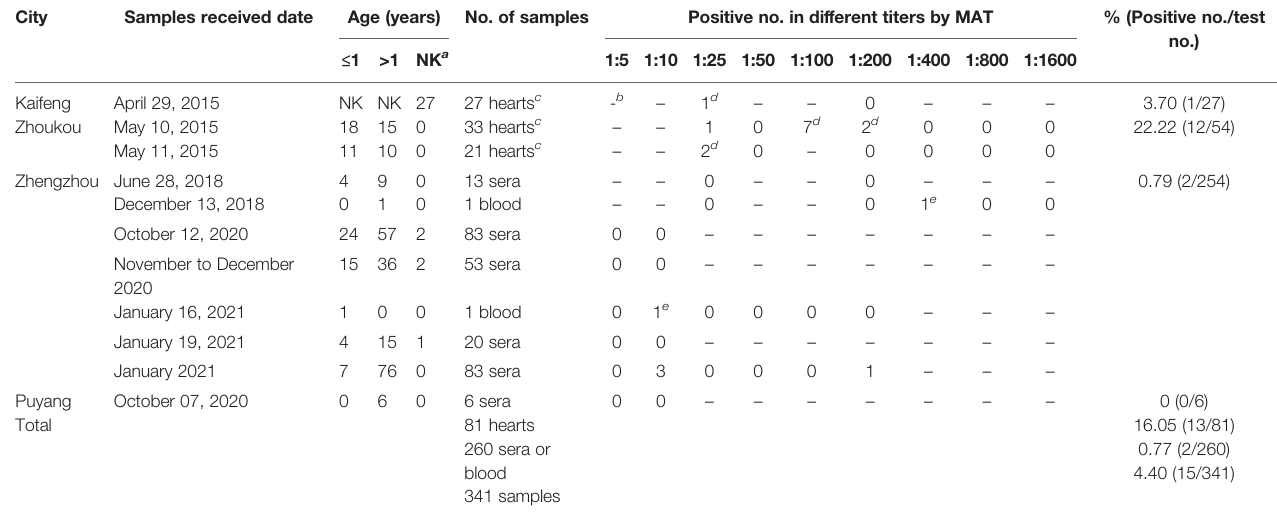
TABLE 1 | Serological investigation of Toxoplasma gondii infection in dogs from Henan Province, China. City